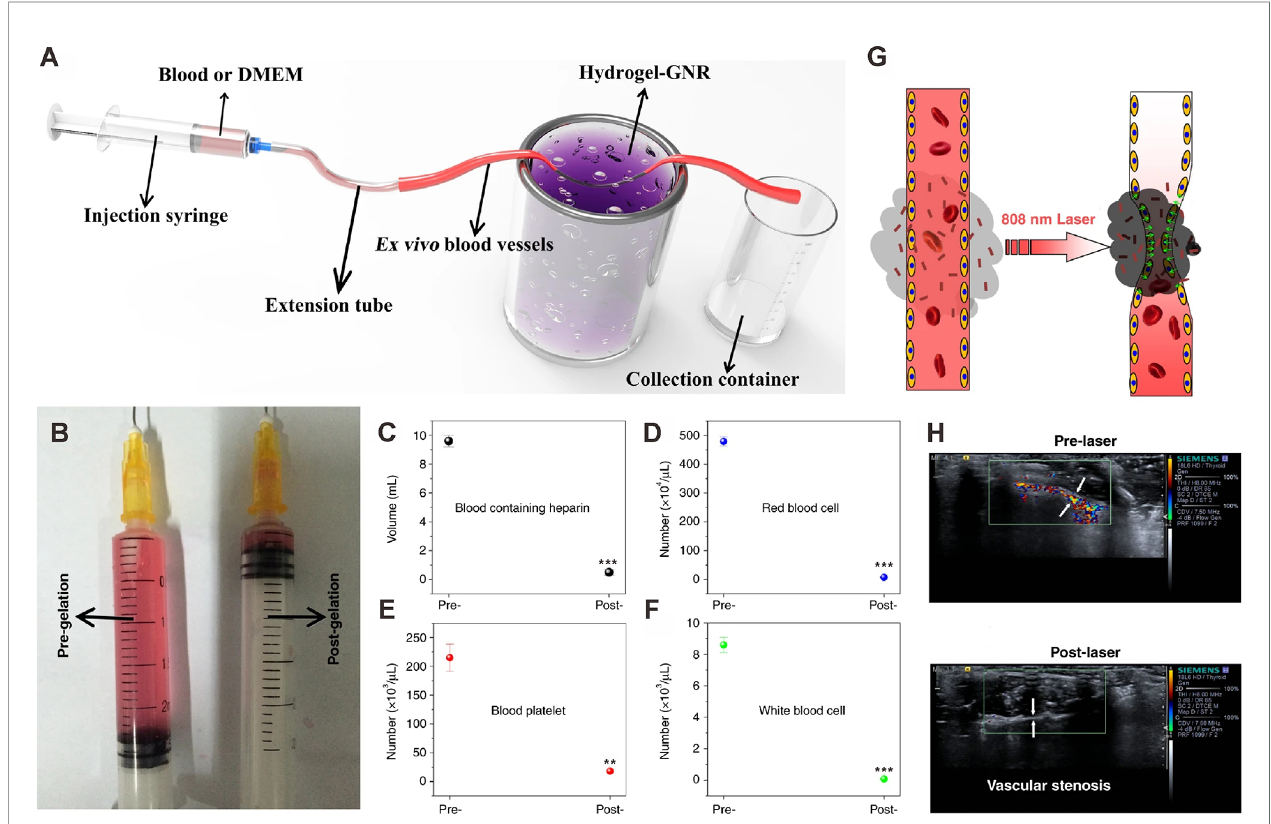
FIGURE 4 | Occlusion of blood supply in ex vivo and in vivo artery models. (A) Schematic of the experimental apparatus for evaluating vessel occlusion ex vivo in blood vessels (with an inner diameter of 1.00 mm) treated with the gelation shrinkage-induced internal stress platform. (B) Traversed volume of DMEM in the ex vivo blood vessel model before (left) and after (right) gelation of hydrogel-GNR. (C – F) Collected blood volume (C) , red blood cells (D) , blood platelet (E) , and white blood cells (F) traversed through ex vivo blood vessels using rabbit blood containing heparin. **P<0.01 and ***P<0.001 compared to pre-gelation; determined using Student ’ s t-test. (G) Schematic representation of the extravascular gelation shrinkage-induced internal stress system irradiated with 808 nm laser. (H) CDFI images of abdominal arteries of nude mice treated which hydrogel-GNR. CDFI images were captured before and after irradiation with an 808 nm laser. White arrows indicate the blood vessels of the abdominal artery. Reprinted with permission from Springer Nature